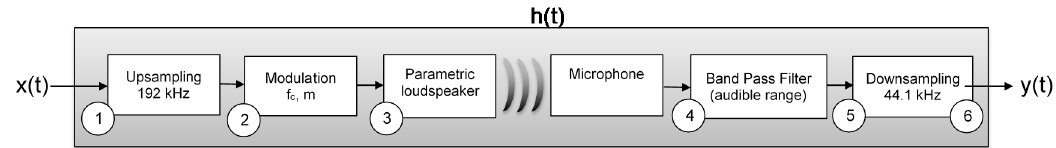
Figure 2. Block diagram of the transfer function measurement method in an ultrasonic parametric 20 array. 21